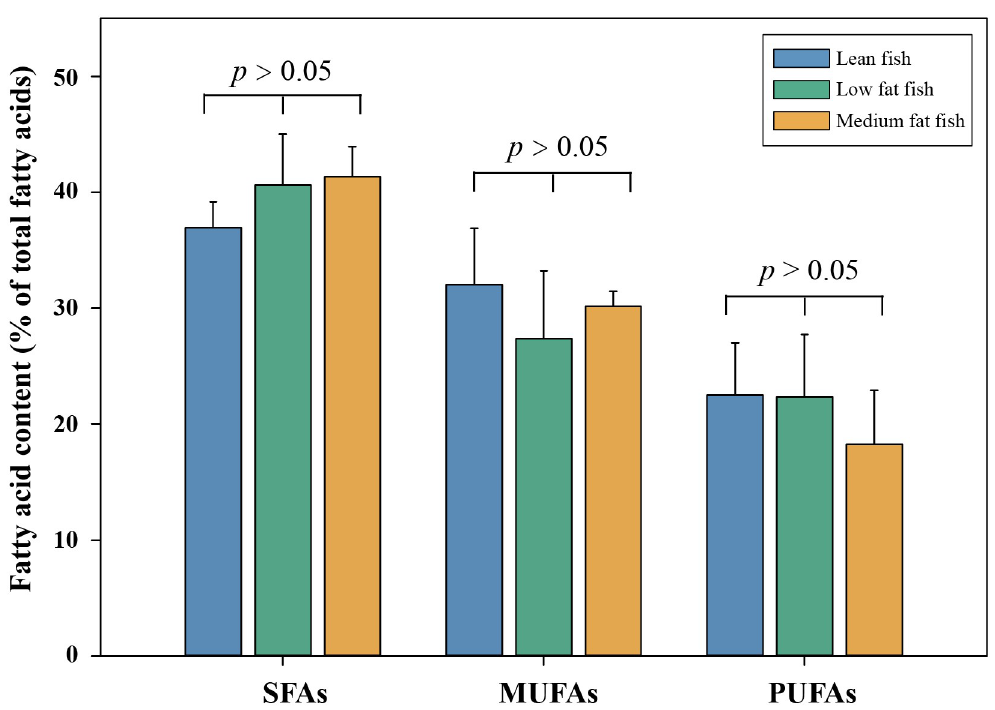
Fig 1. Differences in fatty acid signatures among the analyzed fish from different lipid